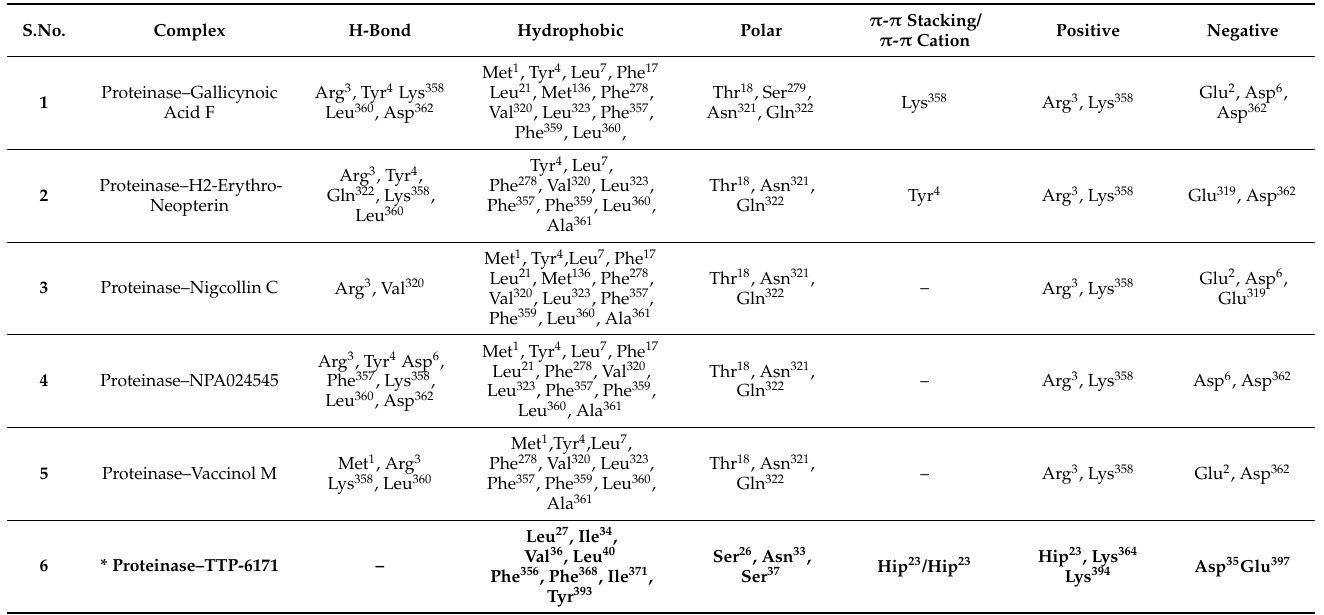
Table 2. List of interacting residues and type of interactions from cysteine protease protein of MPXV with the top five hits and * reference native ligand